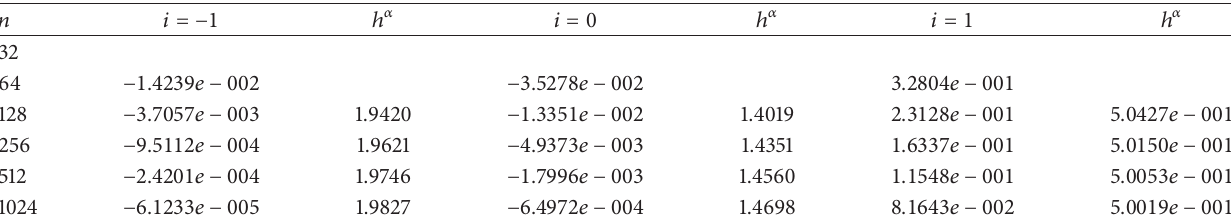
Table 6: A posteriori error estimate of the mod-trapezoidal